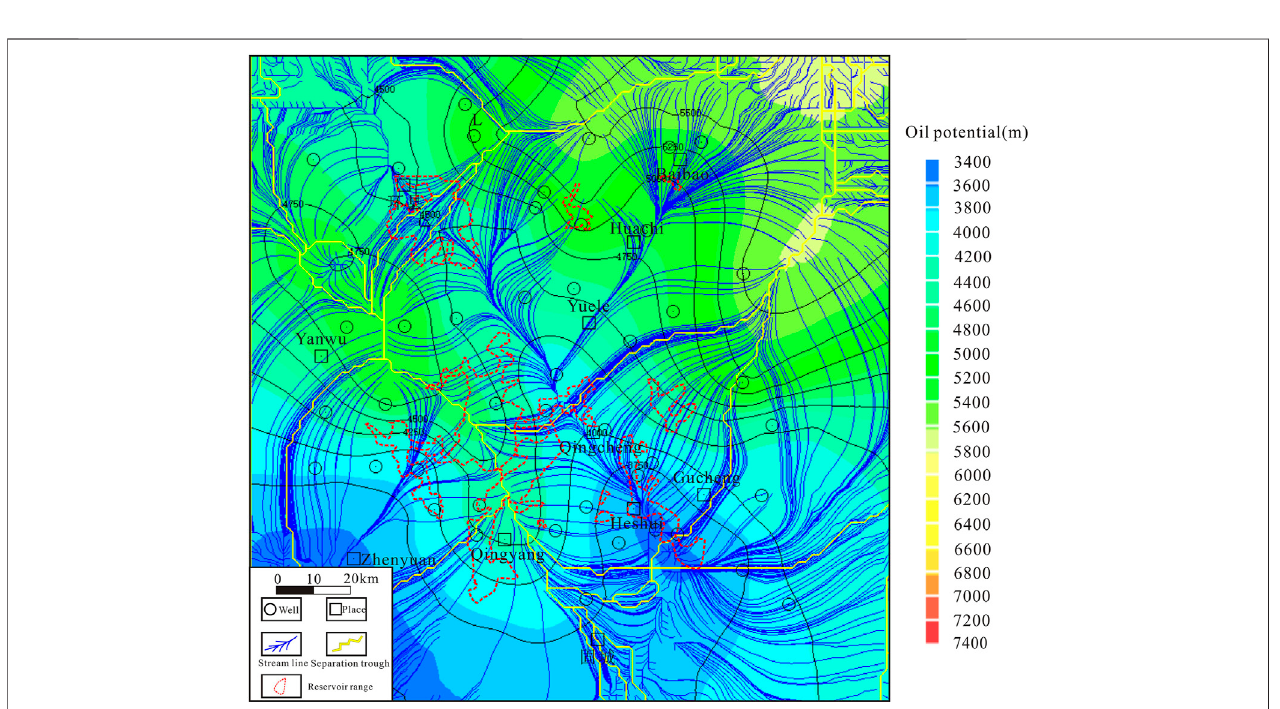
FIGURE 11 | Oil potential and streamlines for the Chang 8 member during the main reservoir-forming period in the Longdong area.